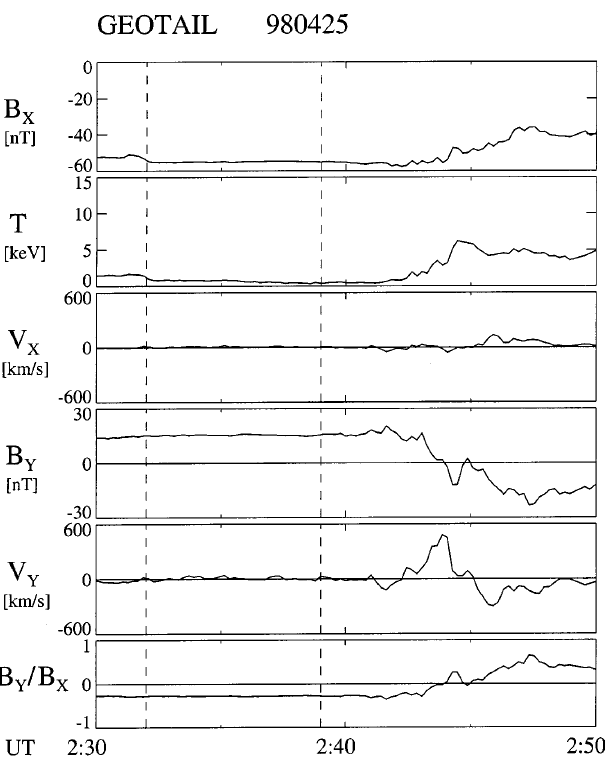
Fig. 9. Magnetic field and plasma moments between 0230 and 0250 UT for Geotail in the same format as Fig.